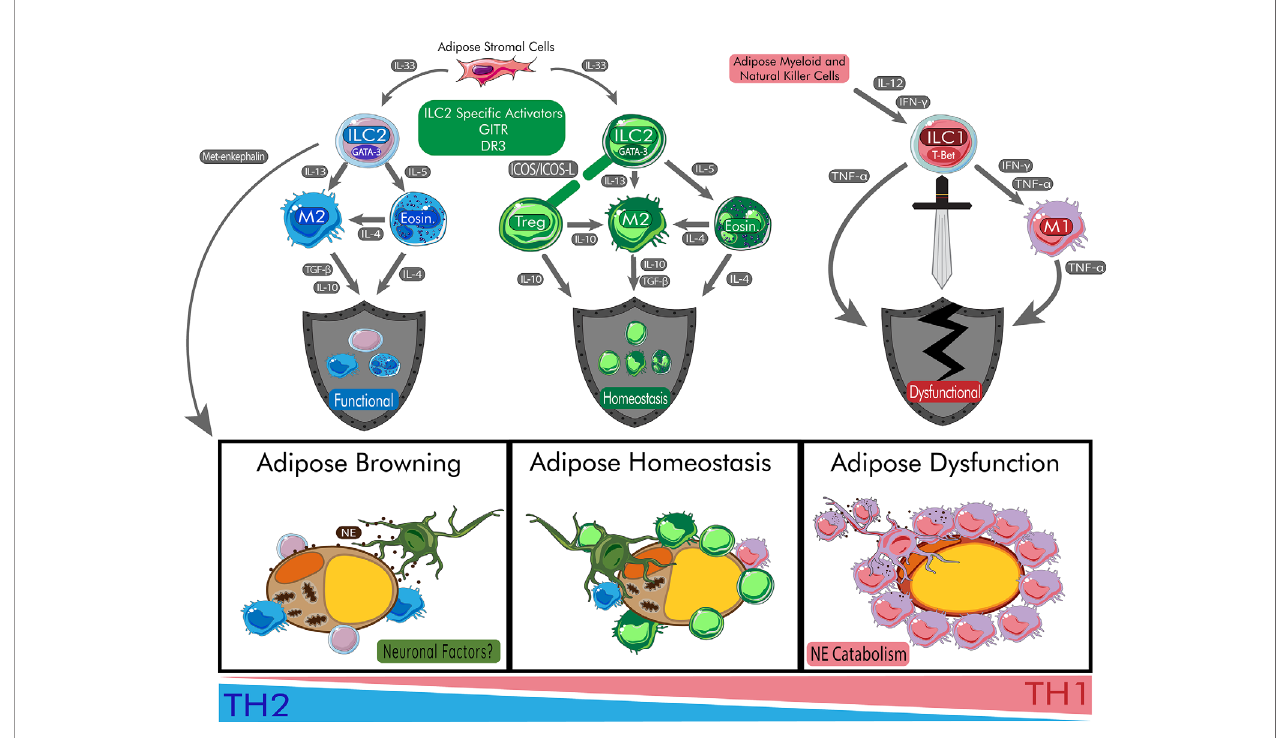
FIGURE 1 | Role of ILC2s in Protecting Adipose Homeostasis and Promoting Beige Adipocytes. ILC2s begin a cascade of anti-in fl ammatory effects on the adipose tissue which allow for the browning of adipose tissue. During browning, adipocytes increase mitochondrial output and browning genes. Peripheral nerves are protected by ILC2s and communicate through neuronal factors such release of neuropeptides. In homeostasis, the balance of in fl ammation is maintained via healthy response to peripheral signals. During metabolic disturbances, the cytokines IL-12 and IFN- g polarize ILC progenitors to become ILC1s responsible for damage of adipose tissue and systemic dysfunction. During this process, M1 macrophages are recruited to the adipose tissue and catabolize catecholamines like NE leading to insulin resistance. Chronic release of TNF- a also contribute to poor responses to insulin and T2DM. DR3, death receptor 3; Eosin, eosinophil; GITR: Glucocorticoid- Induced TNFR-Related protein; ICOS, inducible T-cell co-stimulator; IFN- g , interferon gamma; IL, interleukin; ILC1, type 1 innate lymphoid cell; ILC2, type 2 innate lymphoid cell; M1, type 1 macrophage; M2, type 2 macrophage; NE, norepinephrine; T-bet, t-box transcription factor TBX21; TGF- b , transforming growth factor beta; TNF- a , tumor necrosis factor alpha; Treg, regulatory T